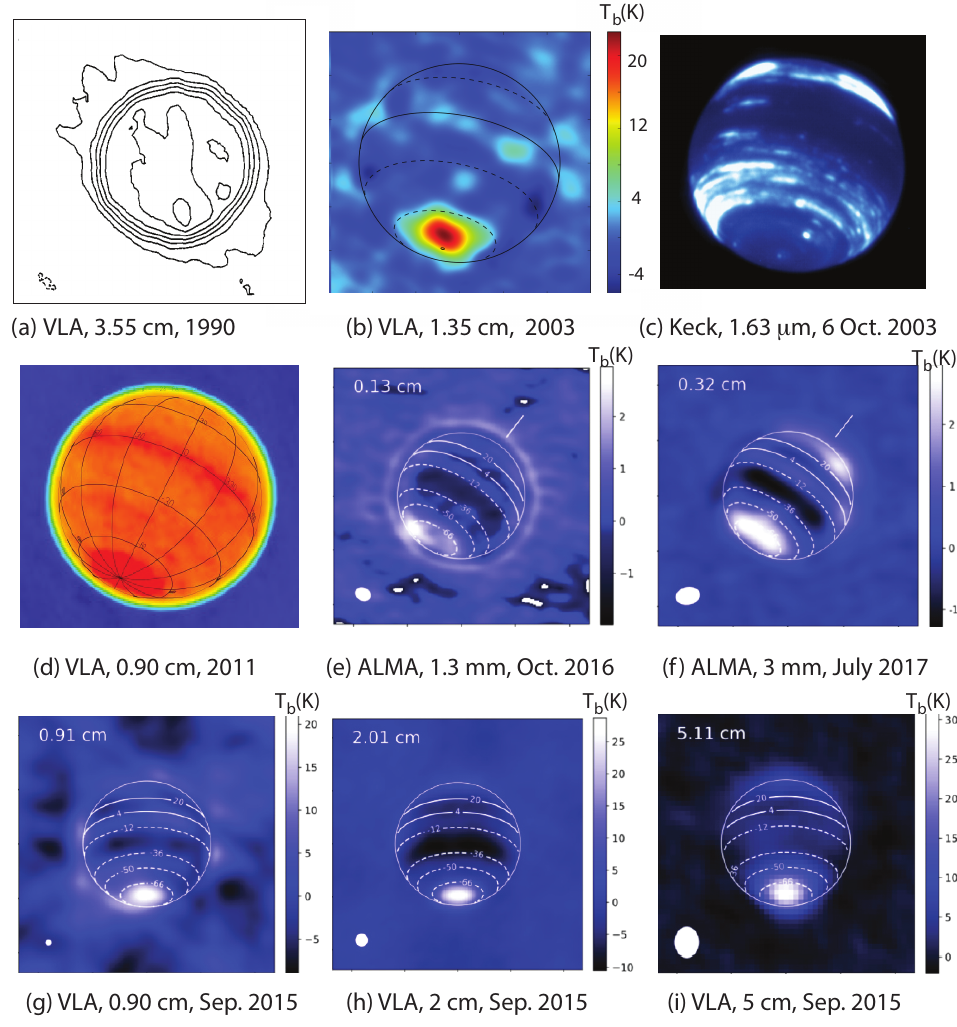
Figure 19. Longitude-smeared maps of Neptune taken with ALMA and the VLA. ( a ) Early VLA map at 3.55 cm; this map already shows a brightness enhancement near Neptune’s south pole [144]. ( b ) VLA map from 2003, after subtraction of a uniform limb-darkened disk. The color bar indicates the brightness temperature residuals in Kelvin [27]. ( c ) Image at infrared wavelengths taken with the Keck telescope. ( d ) VLA map in 2011 after its upgrade [146]. ( e , f ) ALMA maps, after subtraction of a uniform limb-darkened disk [147]. ( g – i ) VLA maps from 2015, after subtraction of a uniform limb-darkened disk [16]. Panels ( e – i ): The color bar indicates the brightness temperature residuals in Kelvin. Contour lines delineate the latitude transitions between bands. Neptune’s disk is outlined with a white ellipse. The FWHM of the beam is indicated in white in the bottom left of each